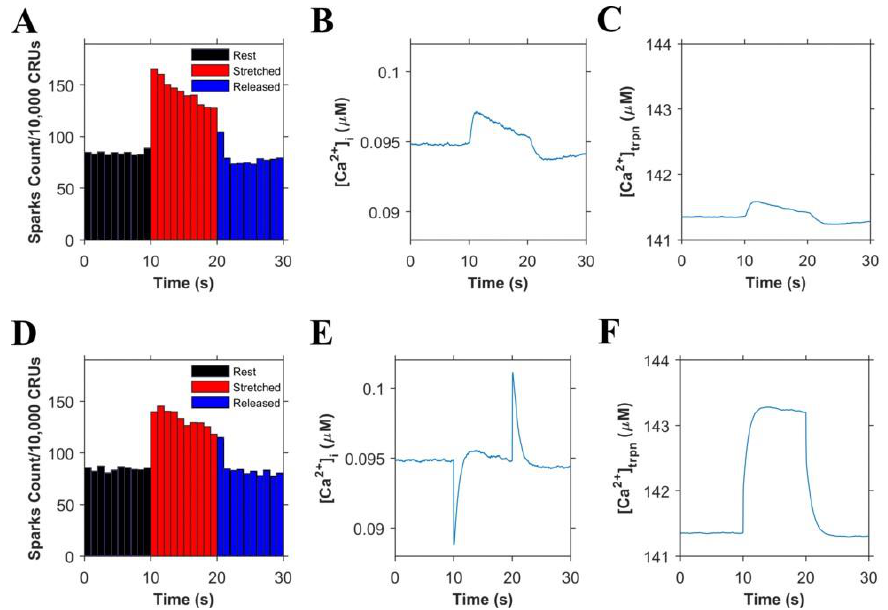
Figure 2 . Simulation results (n = 20 simulations) in resting cells. ( A – C ). Simulations in which troponin’s affinity to Ca 2+ does not increase during the stretching of cardiomyocytes: A . Ca 2+ sparks histograms for 1 s bins. B . Concentration of Ca 2+ in the myoplasm ([Ca 2+ ] i ). C . Concentration of Ca 2+ bound to troponin ([Ca 2+ ] trpn ). ( D – F ). Simulations in which troponin’s affinity to Ca 2+ increases during the stretching of cardiomyocytes: D . Ca 2+ sparks histograms for 1 s bins. E . Concentration of Ca 2+ in the myoplasm ([Ca 2+ ] i ). F . Concentration of Ca 2+ bound to troponin ([Ca 2+ ] trpn ).